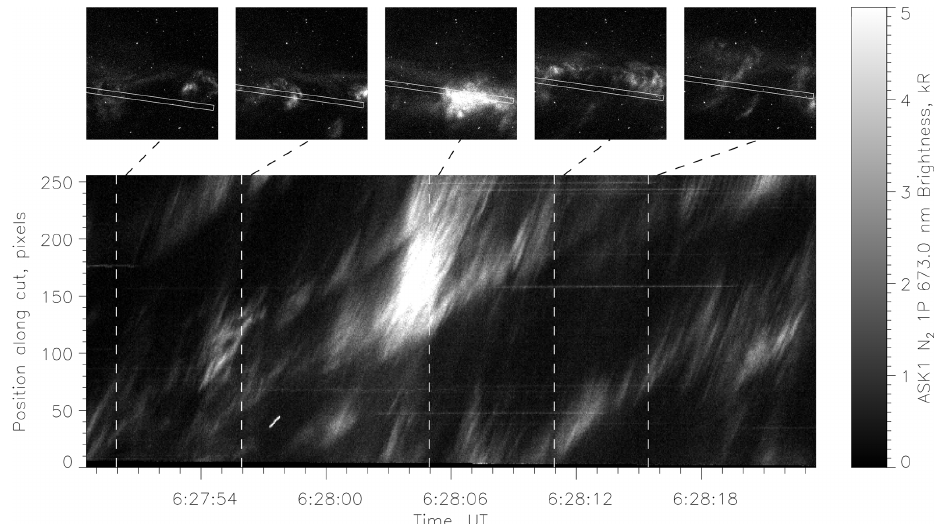
Figure 9. ASK1 (N 2 1P) keogram made using a moving cut to track the FAEs in event 2a. White dashed lines mark the times of the images shown above the keogram. The white boxes indicated in the images show the location of the keogram cut.